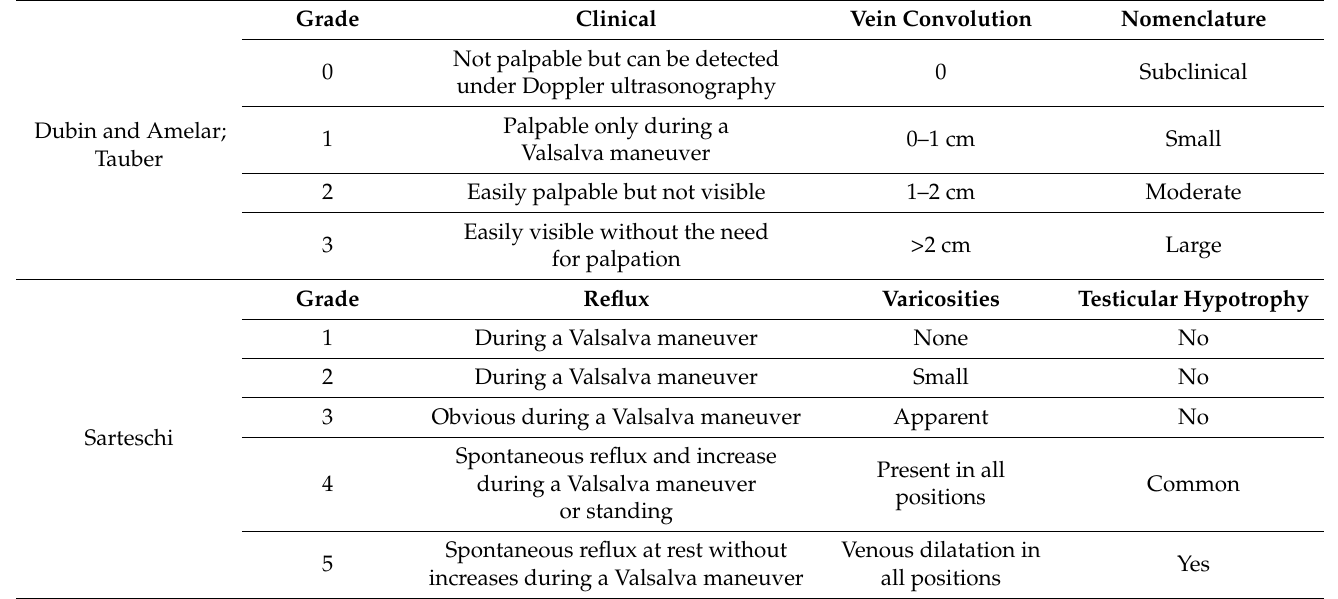
Table 1. Classification of